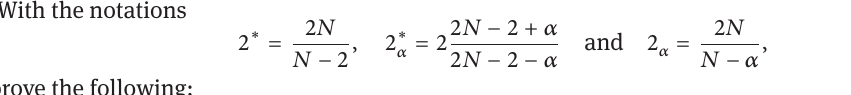
With the notations